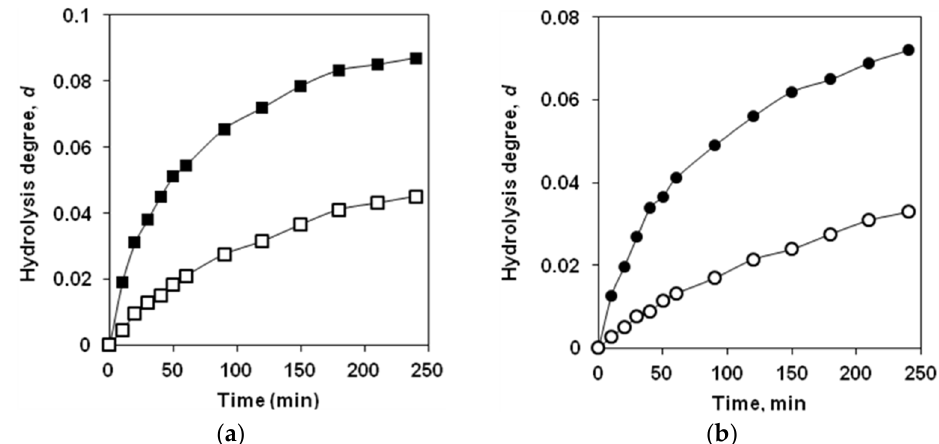
Figure 3. Dependences of the degree of hydrolysis on proteolysis time: ( a ) proteolysis of β -LG (0.25 g/L) by trypsin at a concentration of 5 ( ■ ) and 1 mg/L ( □ ); ( b ) proteolysis of β -CN (0.25 g/L) by trypsin at a concentration of 0.5 ( • ), and 0.1 mg/L ( (cid:35)